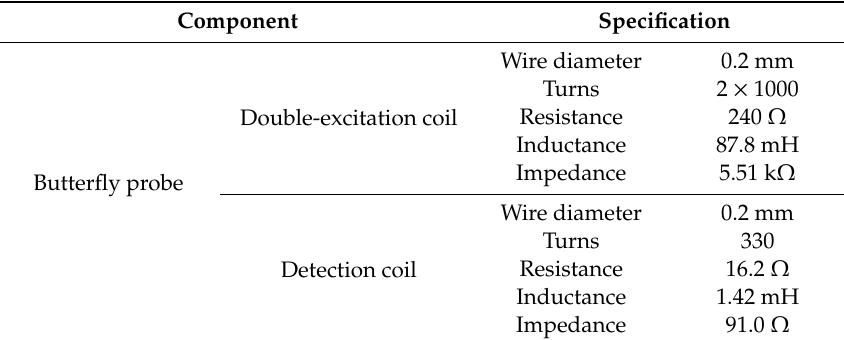
Table 3. Size of flaws on test piece surface.